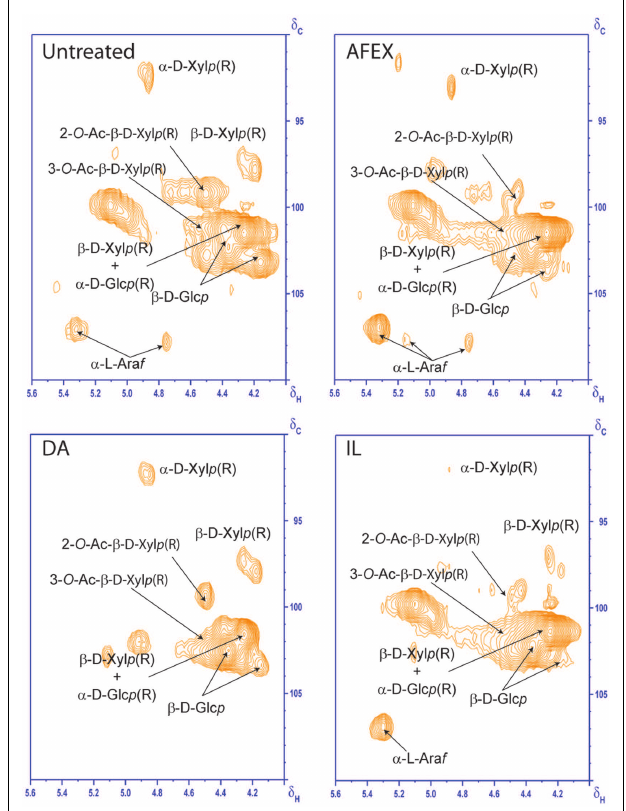
FIGURE 6 |Anomeric region of HSQC NMR spectra of untreated and pretreated corn stover samples .